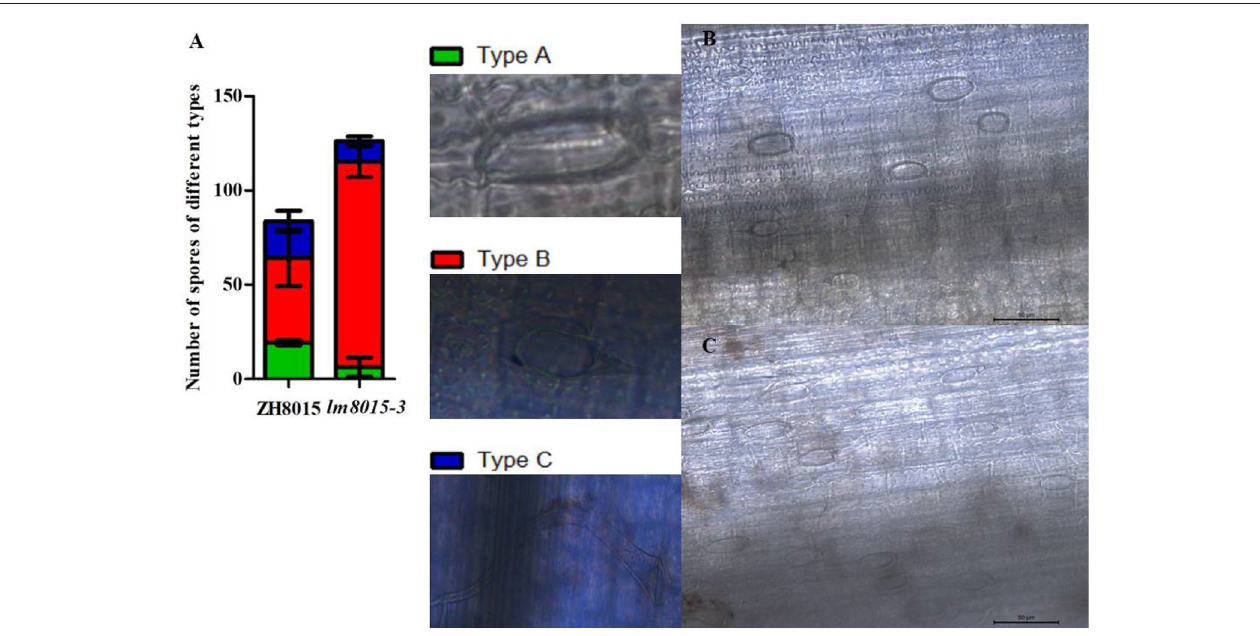
FIGURE 6 | Statistics of different spore types of ZH8015 and lm8015-3 at 72h after inoculation. (A) Graph of different types of spores of 3-week-old ZH8015 and lm8015-3 at 72h after inoculation; Error bars represent SD ( n = 3). (B,C) The 72-h–inoculated leaf sheath of 3-week-old ZH8015 and lm8015-3 . Type A, uninfected conidium; Type B, germinating conidium; Type C, successfully infected